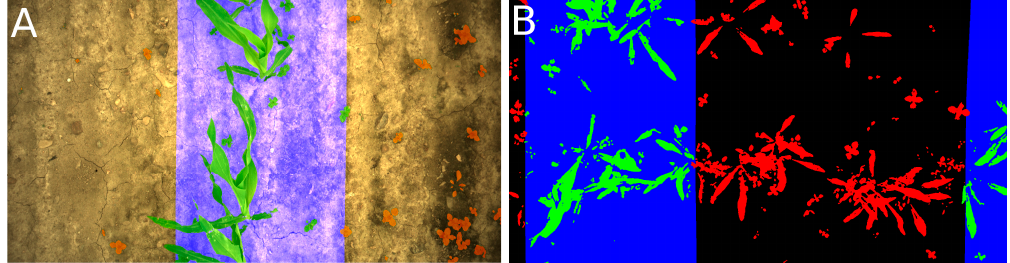
Figure 8. Images from spray session 2 illustrating the inter-row area used to estimate weed coverage. ( A ) The camera is centered above the crop row. The green color represents plant pixels belonging to the estimated crop band (blue), and the red color represents weed pixels belonging to the estimated inter-row area; ( B ) Similar to the left sub-figure except that the camera is located between the two crop rows. Furthermore, the image was acquired at the location of an unsprayed seeded weed strip. The soil is colored